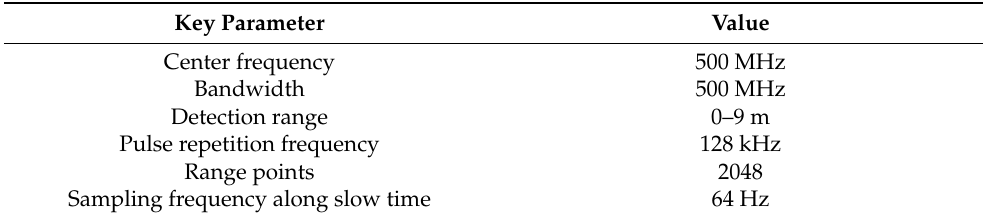
Table 1. Key parameters of the utilized ultrawideband (UWB)